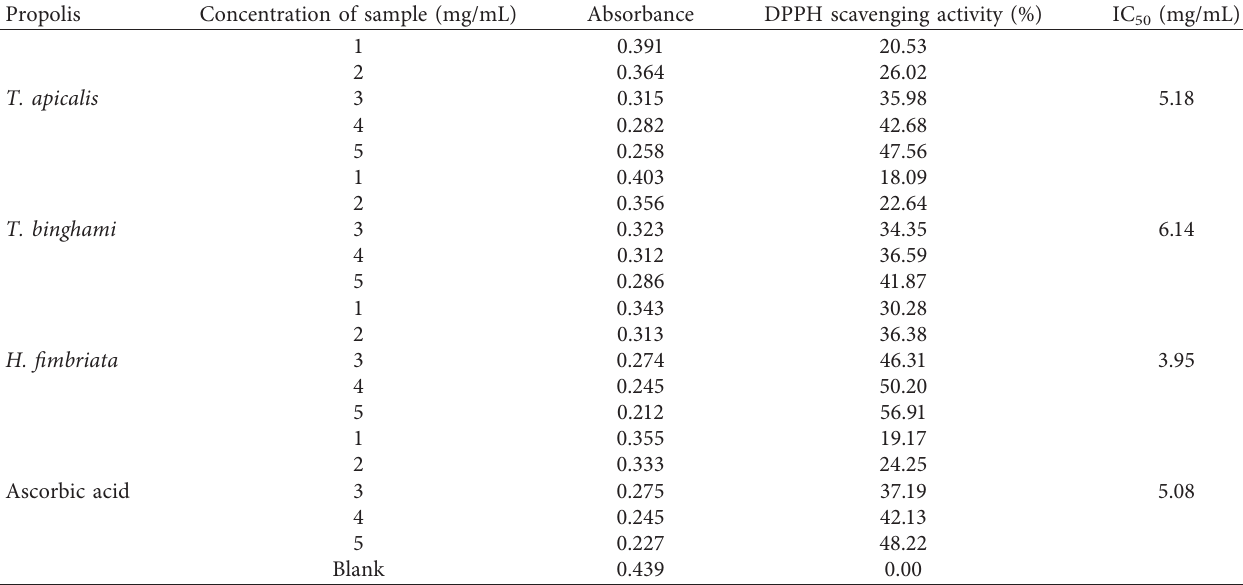
Table 3: Percentage of DPPH scavenging activity and IC